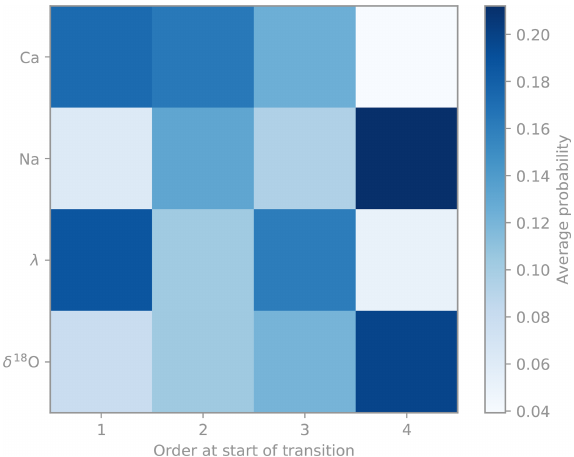
Figure 5. Combined order statistics for the onset of the transi- tion. The colours indicate the probability of observing the onset of the transition in the parameter on the y axis at the position on the x axis. This illustrates that during the onset of the DO warming, the changes in accumulation and Ca 2 + concentrations about equally likely occur first, whereas the transitions in Na + and δ 18 O about equally likely occur